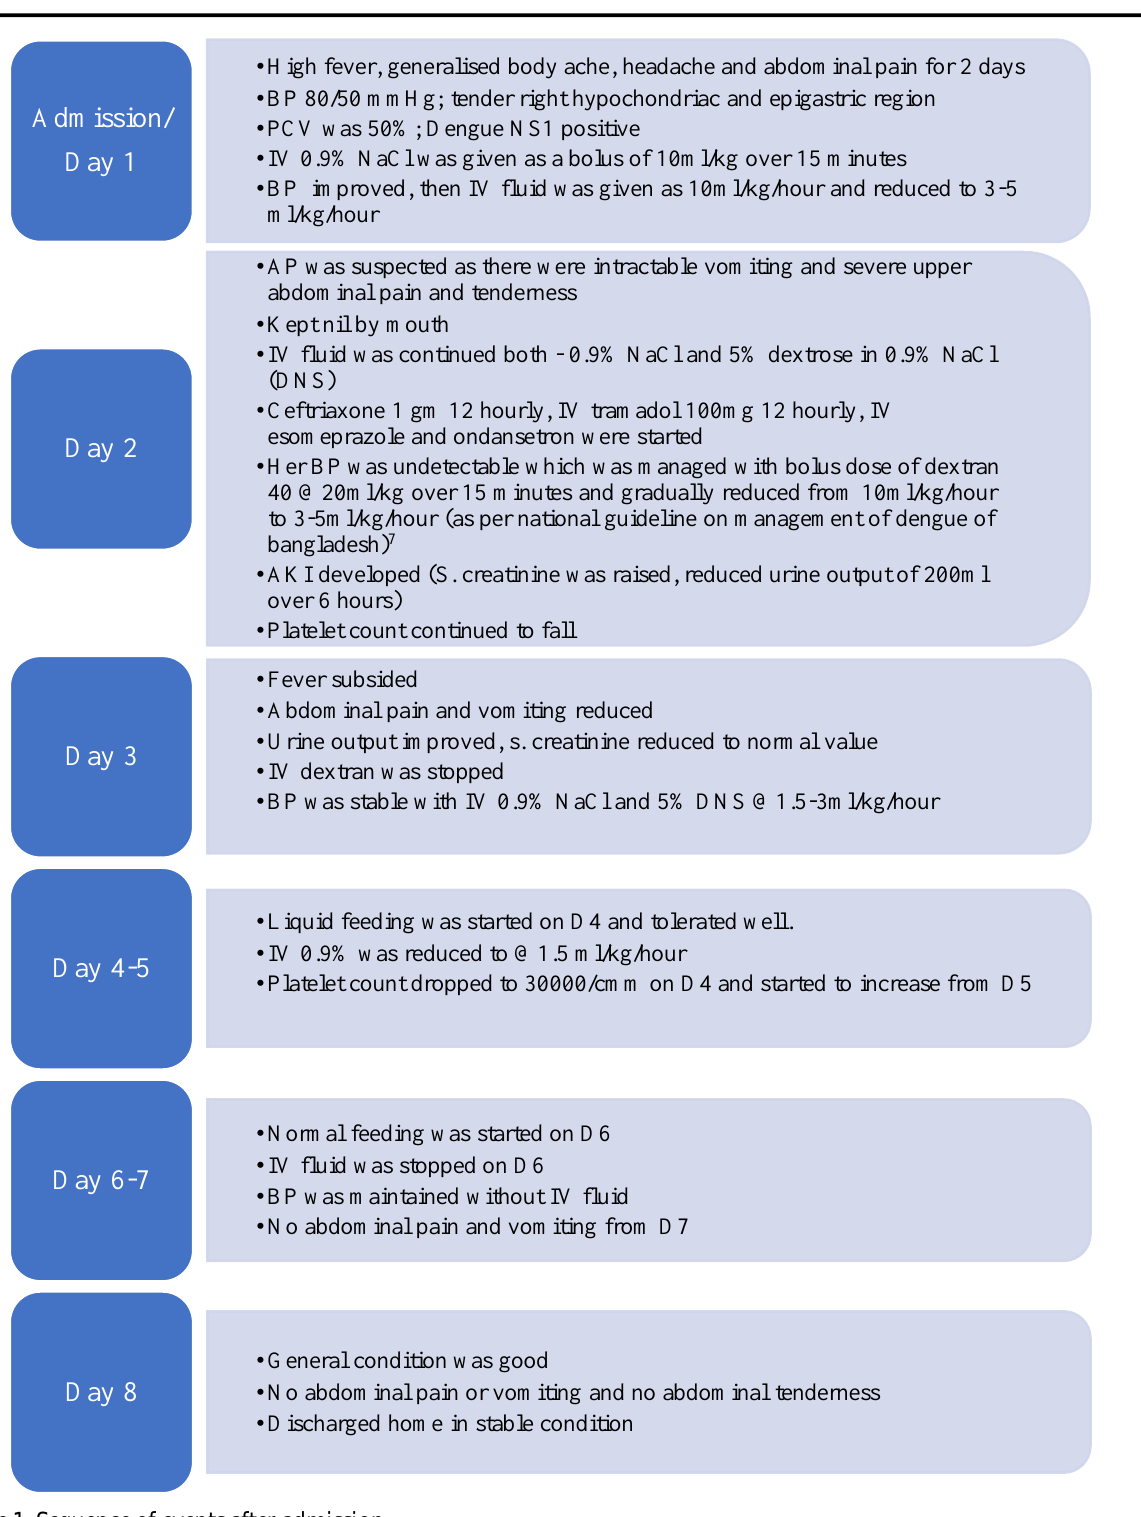
Figure 1: Sequence of events after